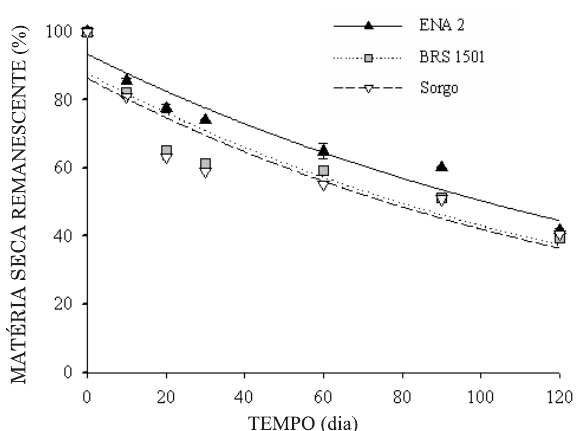
Figura 1. Massa de matéria seca remanescente das plantas de cobertura em avaliações realizadas ao longo do tempo em bolsas de decomposição na superfície do solo. (A equação e a significância dos ajustes estão apresentados no Quadro